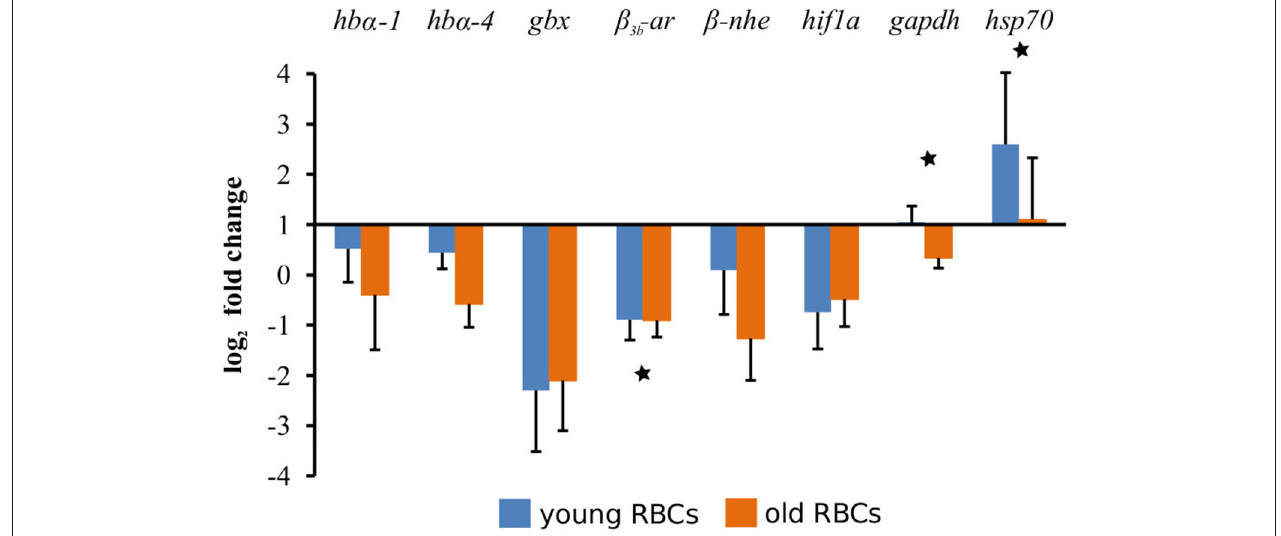
FIGURE 3 | Comparative gene expression levels between young and old erythrocytes (RBCs). Expression of eight target genes was normalized to β -actin as a reference gene and then related to the expression of the respective gene in the original erythrocyte sample taken before the fractionation procedure. Gene abbreviations are hb α -1 , hemoglobin α -1 ; hb α -4 , hemoglobin α -4 ; gbx , globin x1 ; β 3 b -ar , β 3 b -adrenergic receptor ; β -nhe , β -Na + /H + -exchanger ; hif1a , hypoxia inducible factor 1a ; gapdh , glyceraldehyde-3-phosphate dehydrogenase ; hsp70 , inducible heat shock protein 70 kDa . Statistically significant differences between means of young and old erythrocyte fractions is shown by * p < 0.05 .